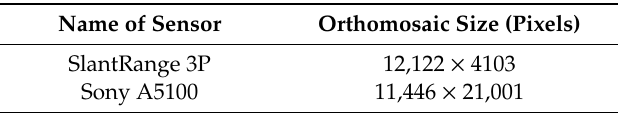
Table 3. Size in pixels of produced orthomosaics according to the used sensors: true-color RGB (Sony A5100) and multispectral